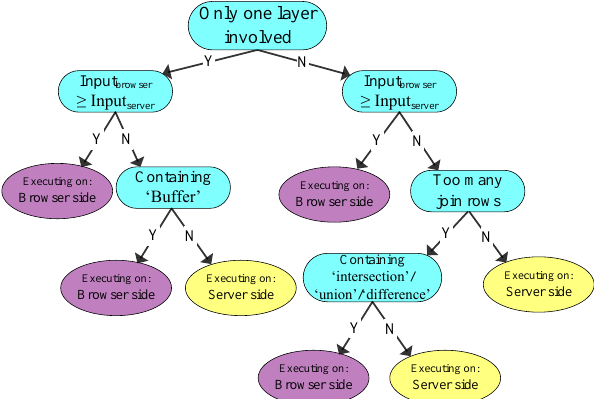
Figure 3. Decision tree for the case when the needed input data are located on both browser and server